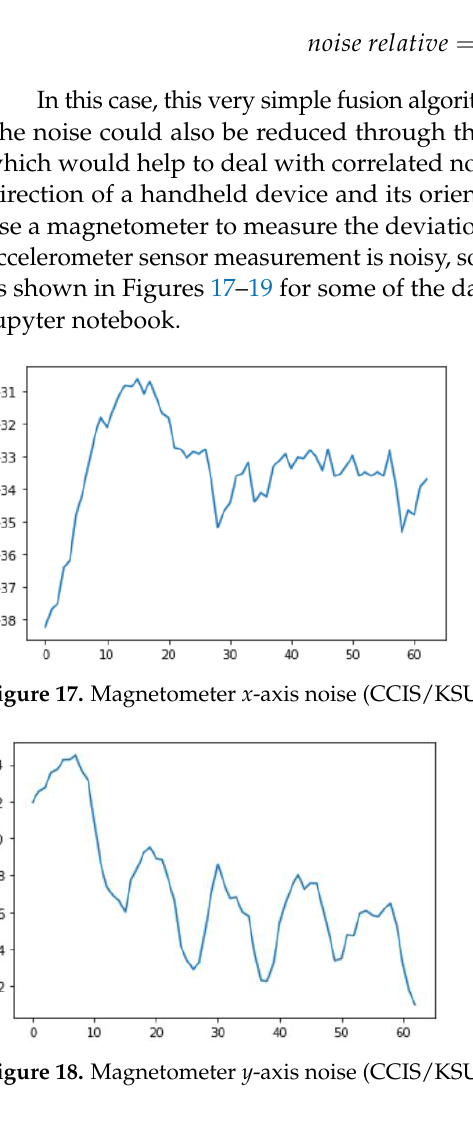
Figure 19. Magnetometer z -axis noise (CCIS/KSU). If we want to reduce the noise, then we may be tempted to add a second magnetom- eter. We considered 10 magnetometers in our case, where Figures 20 – 22 show the noise obtained when using the 10 sensors. To reduce magnetic distortions, certain points such as doors and corners should be used to calculate the magnetic disturbance, and combined with acce sensors to show changes in the corner data when the user/object turns. Then, the magnetic similarity at these points should be recalculated, in order to minimize mag- netic distortions. Figure 20. Merged magnetometer sensor data ( x -axis; CCIS/KSU).